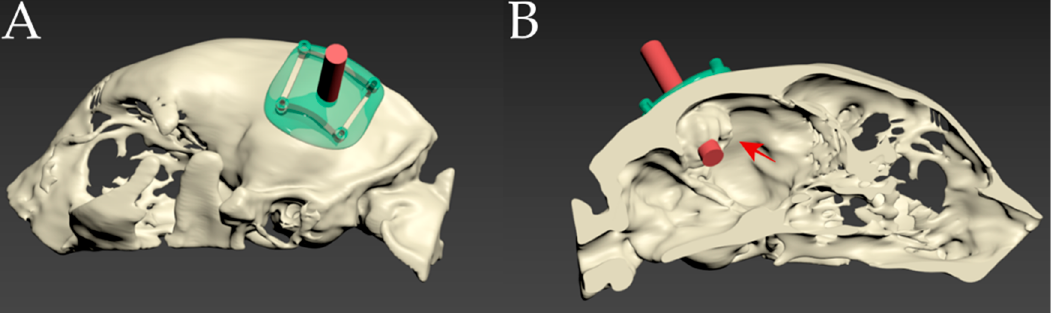
Figure 4. ( A ) Schematic images of the pre-operative skull-contoured three-dimensional (3D) patient- specific surgical guide. ( B ) The tumor (red arrow) is confirmed by a 3D bone model with a sagittal cut of the skull. A 3D tumor-targeting red cylinder passed the center of the tumor.